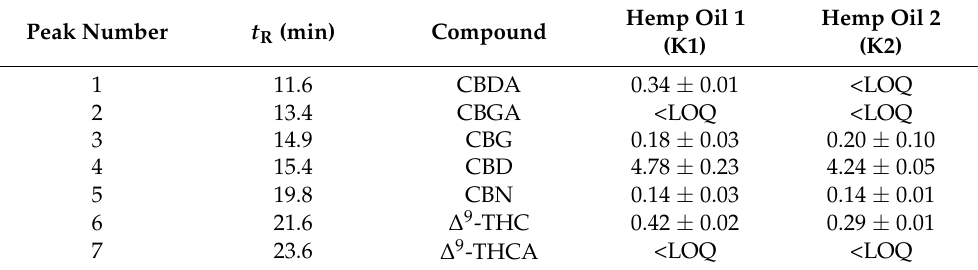
Table 2. Quantification of cannabinoids in hemp oils using HPLC-UV. Data expressed as mg/mL ± SD.